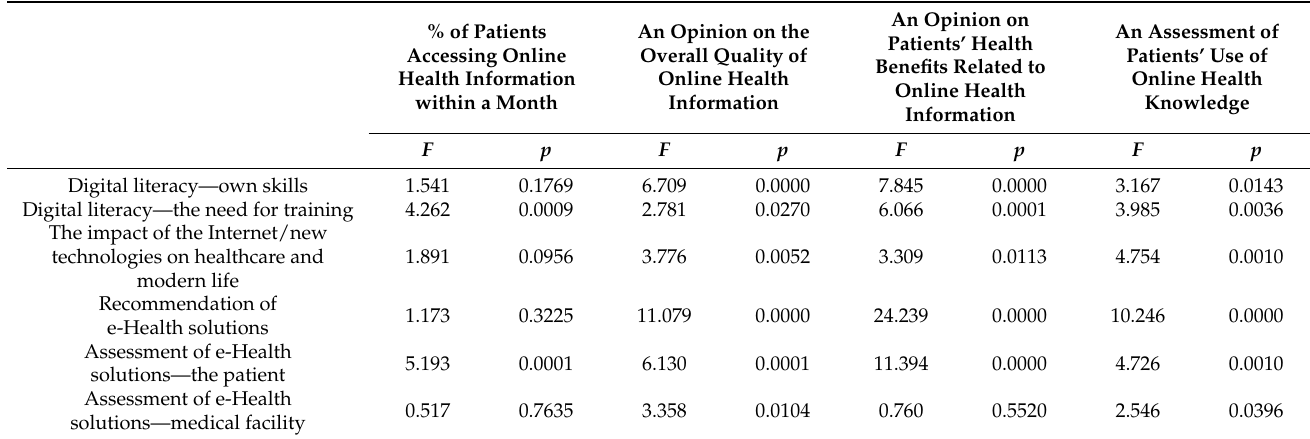
Table 6. Correlation matrix of selected variables.